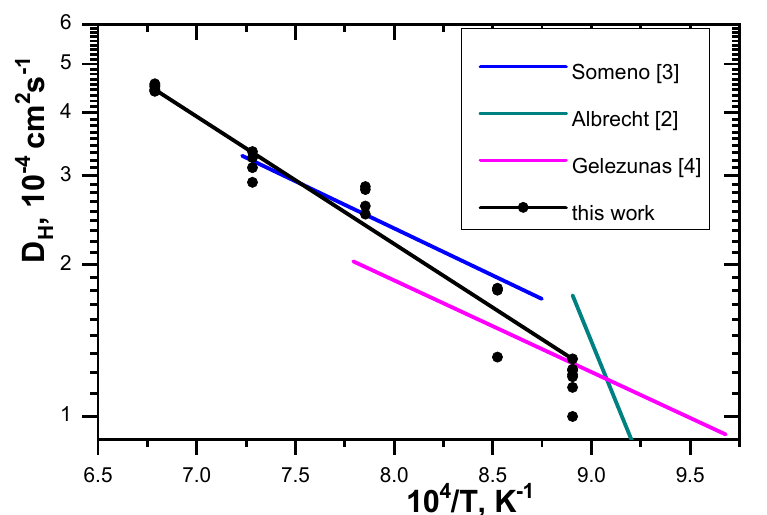
Figure 8. Arrhenius plots of the temperature dependence of the determined diffusivity and tempera- ture correlations given in the literature.